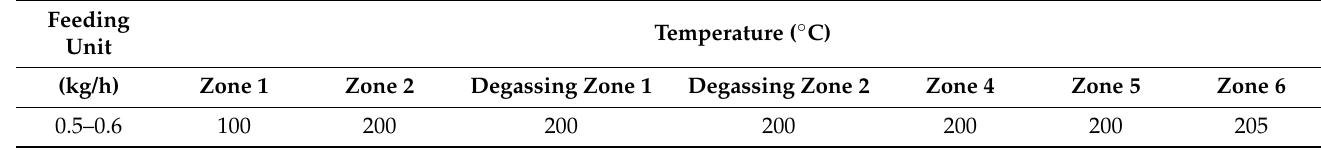
Table 1. Machine data for LDPE degassing and granulation.